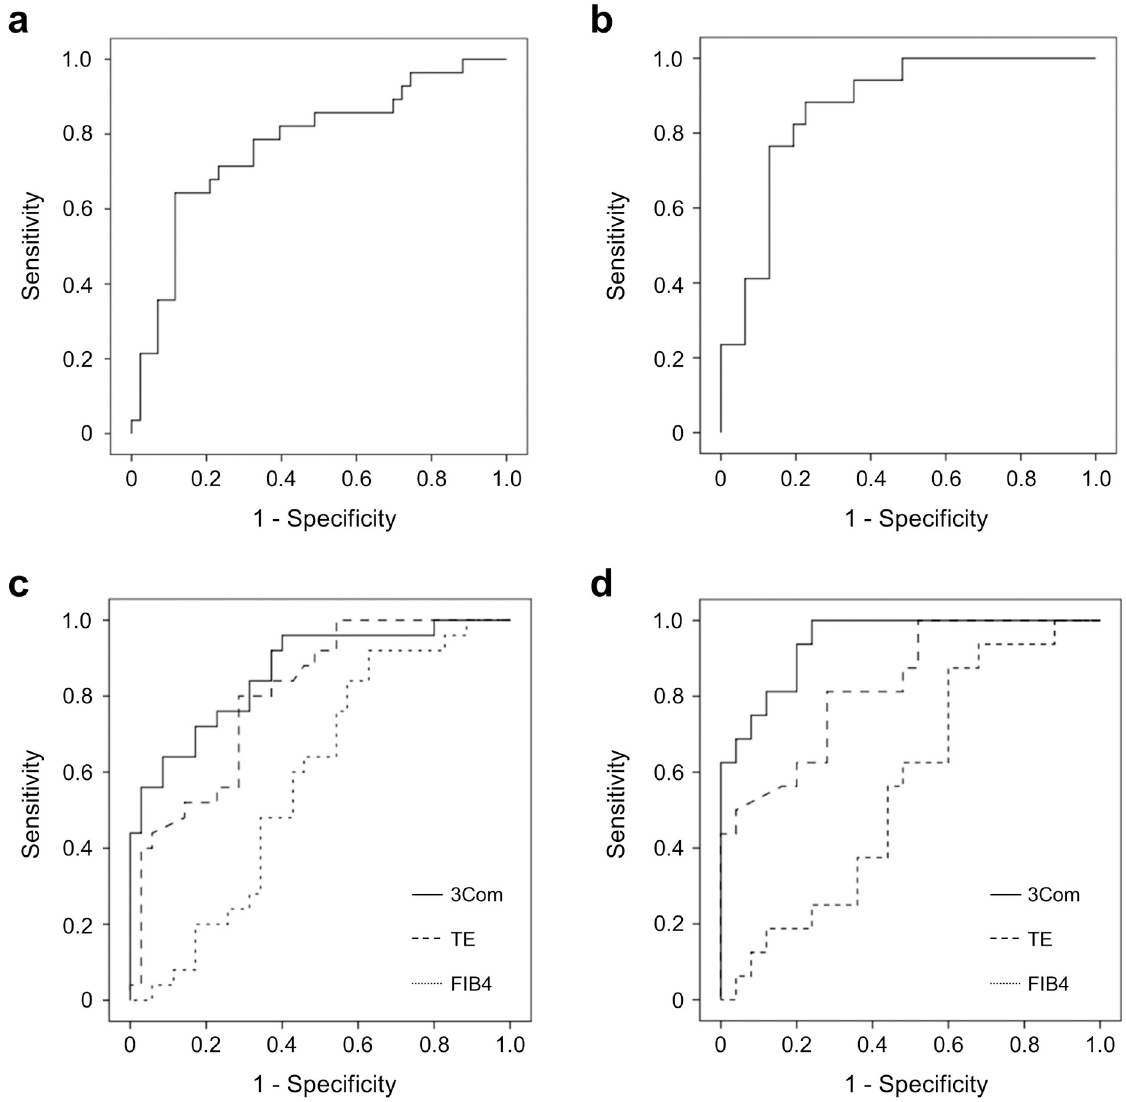
Fig 4. Exosomal miR-122 shows a fair discriminative ability for advanced liver fibrosis. Graphs of miR-122 ROC for (a) total population and (b) non-viral etiological population. Comparison of the ROC between combinational model using miR-122, FIB-4, and TE in (c) total population and (d) non-viral etiological population.